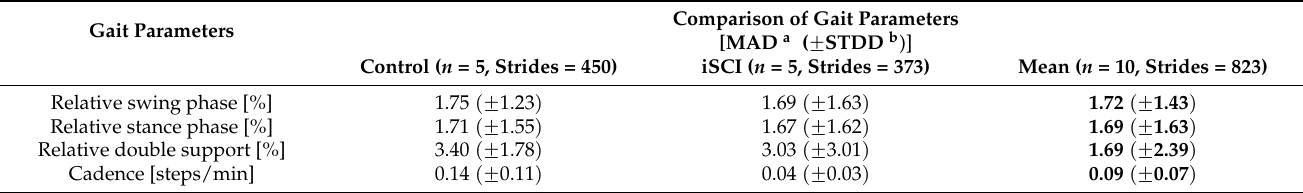
Table 4. Comparison of gait temporal parameters between IMC and OMC systems in control and participants with